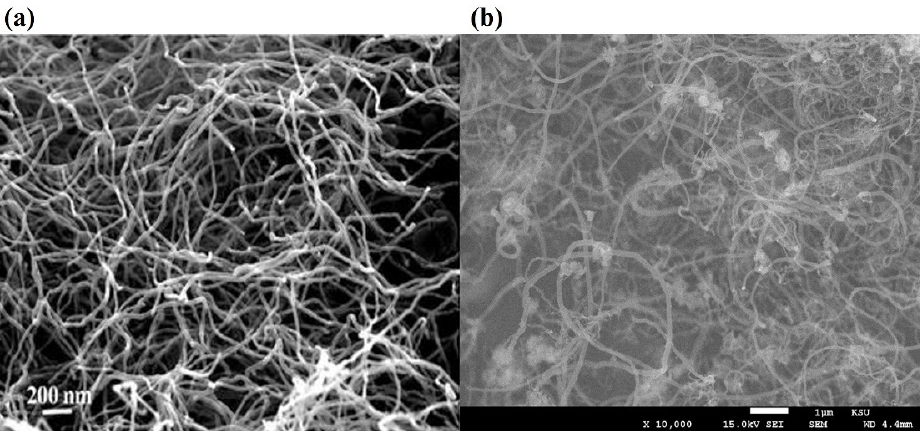
Figure 11. ( a ) FESEM image of carbon fibers deposited over Ni/SiO 2 [41]; ( b ) FESEM image of carbon fibers formed over Fe/Al 2 O 3 [42].